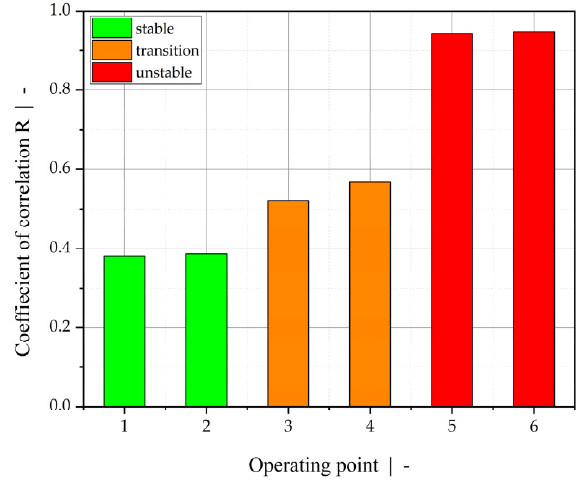
Figure 18. Coefficient of correlation between transient time and amplitude sum for operating points 1–6, based on ultrasound measurement. Process stability is indicated by the color of the bars: stable (green), transition (orange), and unstable/highly unstable (red).